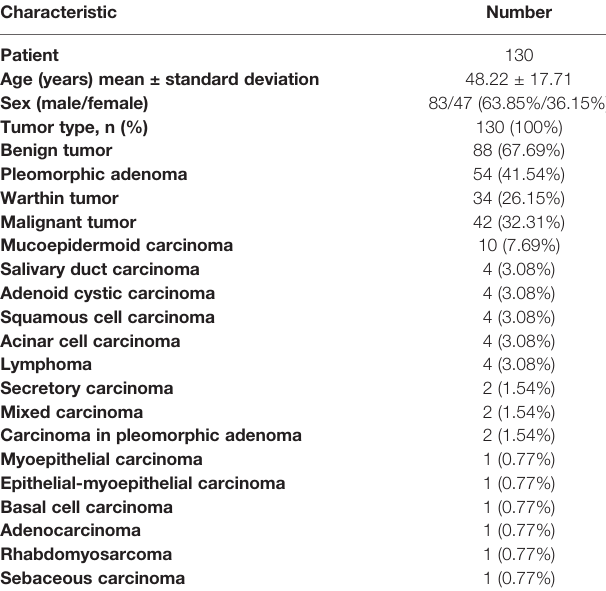
TABLE 1 | Distribution of parotid gland